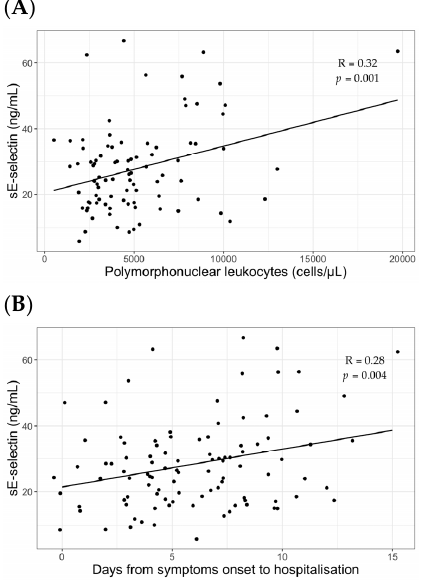
Figure 3. Correlation analyses of sE-selectin with polymorphonuclear leukocytes count ( A ) and days from symptoms onset to hospitalization ( B ).